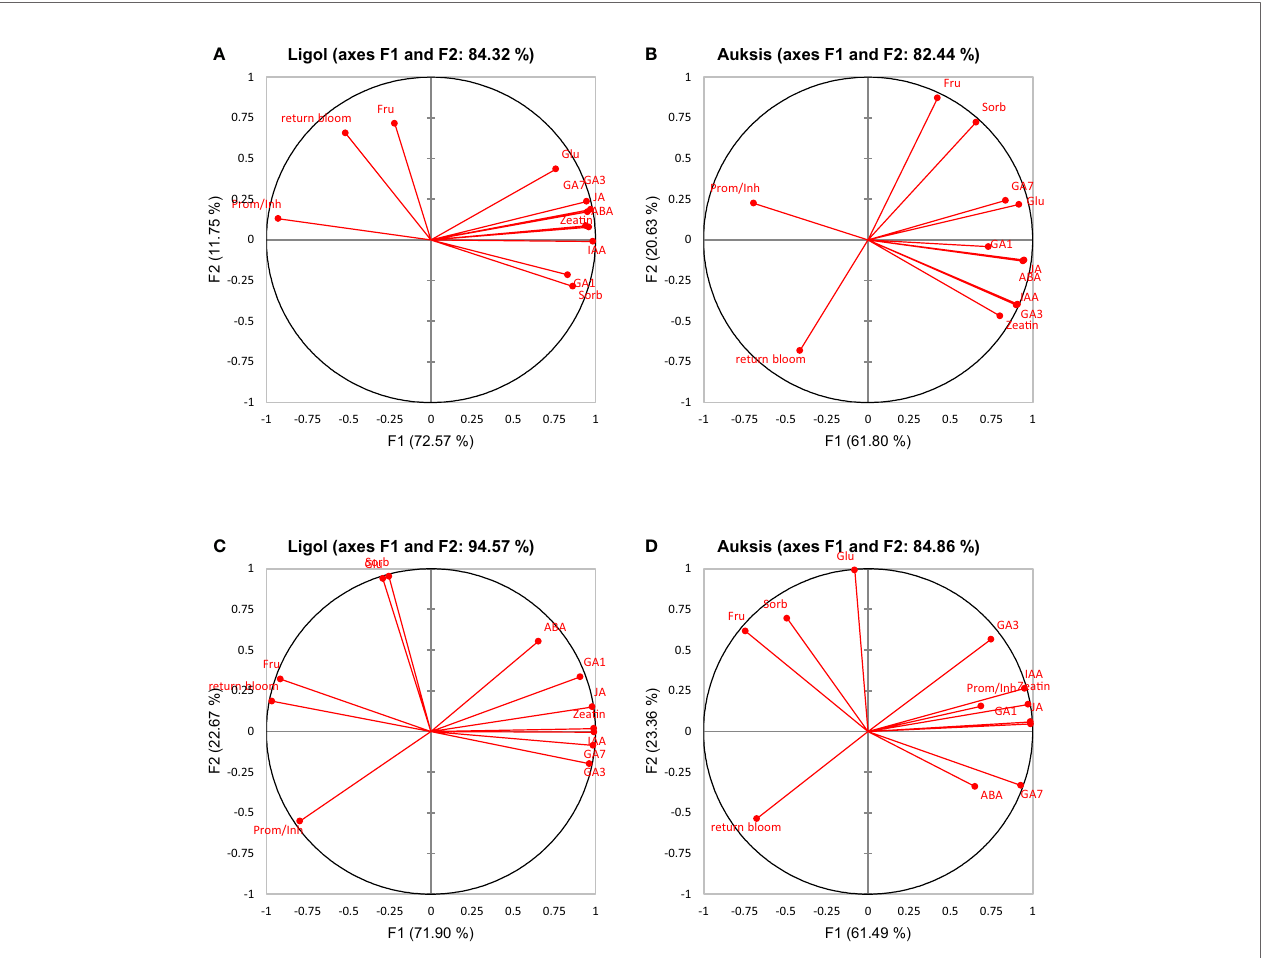
FIGURE 2 | Correlation circle of phytohormones, soluble sugars and return bloom depending on rootstock (A, C) and on crop load (B, D) in “ Ligol ” and “ Auksis ” apple trees respectively. The analysis was conducted with all data resulting from 9 trees of “ Ligol ” and “ Auksis ” apple trees grafted on M.26, M.9, B.396, P 67, and P 22, with crop-load adjusted to 75, 113, and 150 fruits per tree. JA, jasmonic acid; IAA, indolyl-3 acetic acid; ABA, abscisic acid; GA 7 , GA 3 , GA 1 , gibberellins; Glu, glucose; Fru, fructose; Sorb,